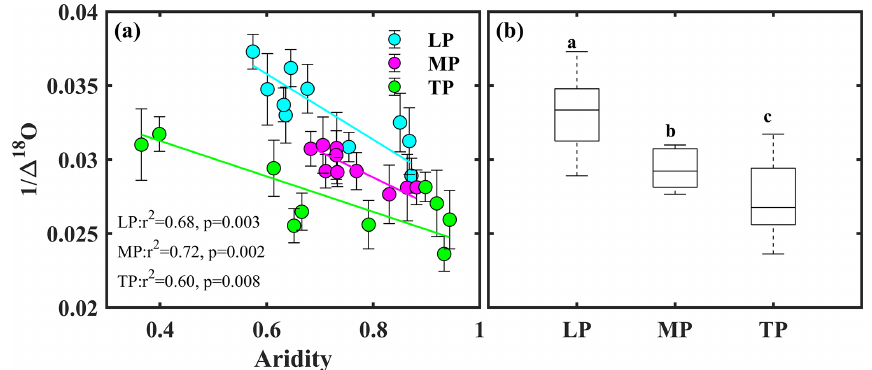
Figure 2. Patterns of community 1 /(cid:49) 18 O along an aridity gradient (a) within transects and (b) among transects. The different letters in panel (b) indicate significant differences ( P< 0 . 001) among transects. (cid:49) 18 O denotes 18 O enrichment above the source water of leaf organic matter, LP represents the Loess Plateau, MP represents the Inner Mongolian Plateau, and TP represents the Tibetan Plateau.